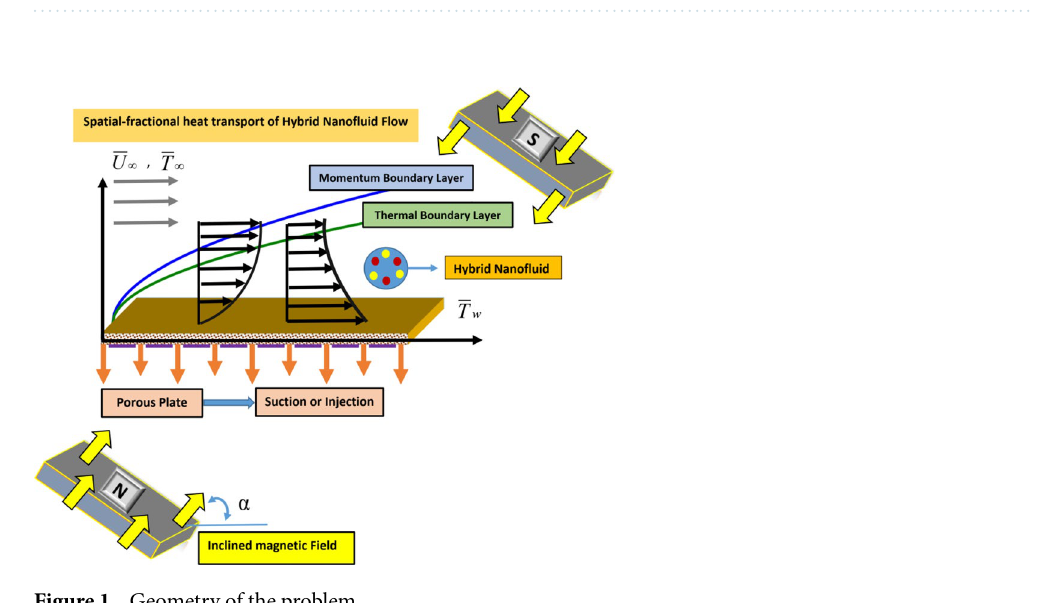
Table 1. Summary of fractional boundary layer problems presented in the literature.